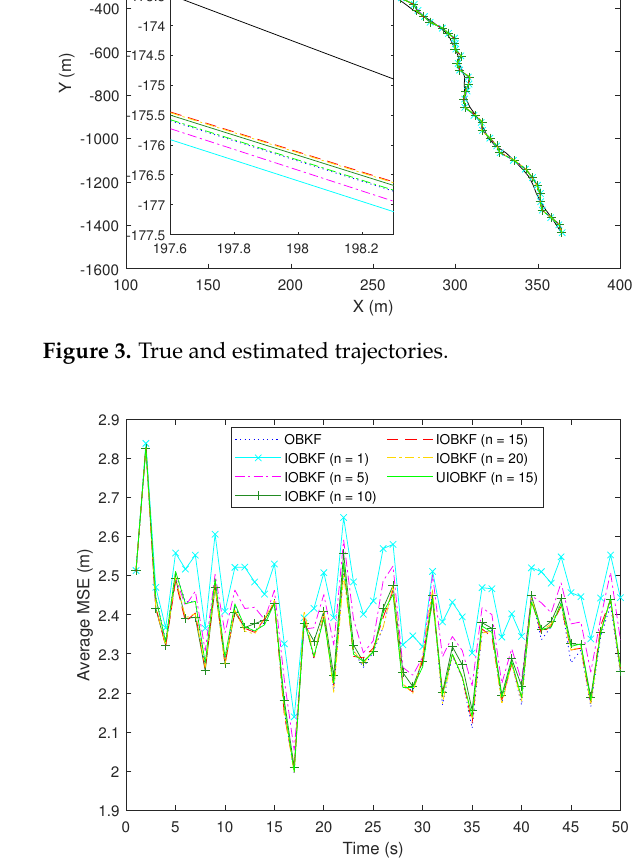
Figure 4. Average MSEs of different algorithms. Table 1. Mean value of MSE and the average time for a single-step operation in different